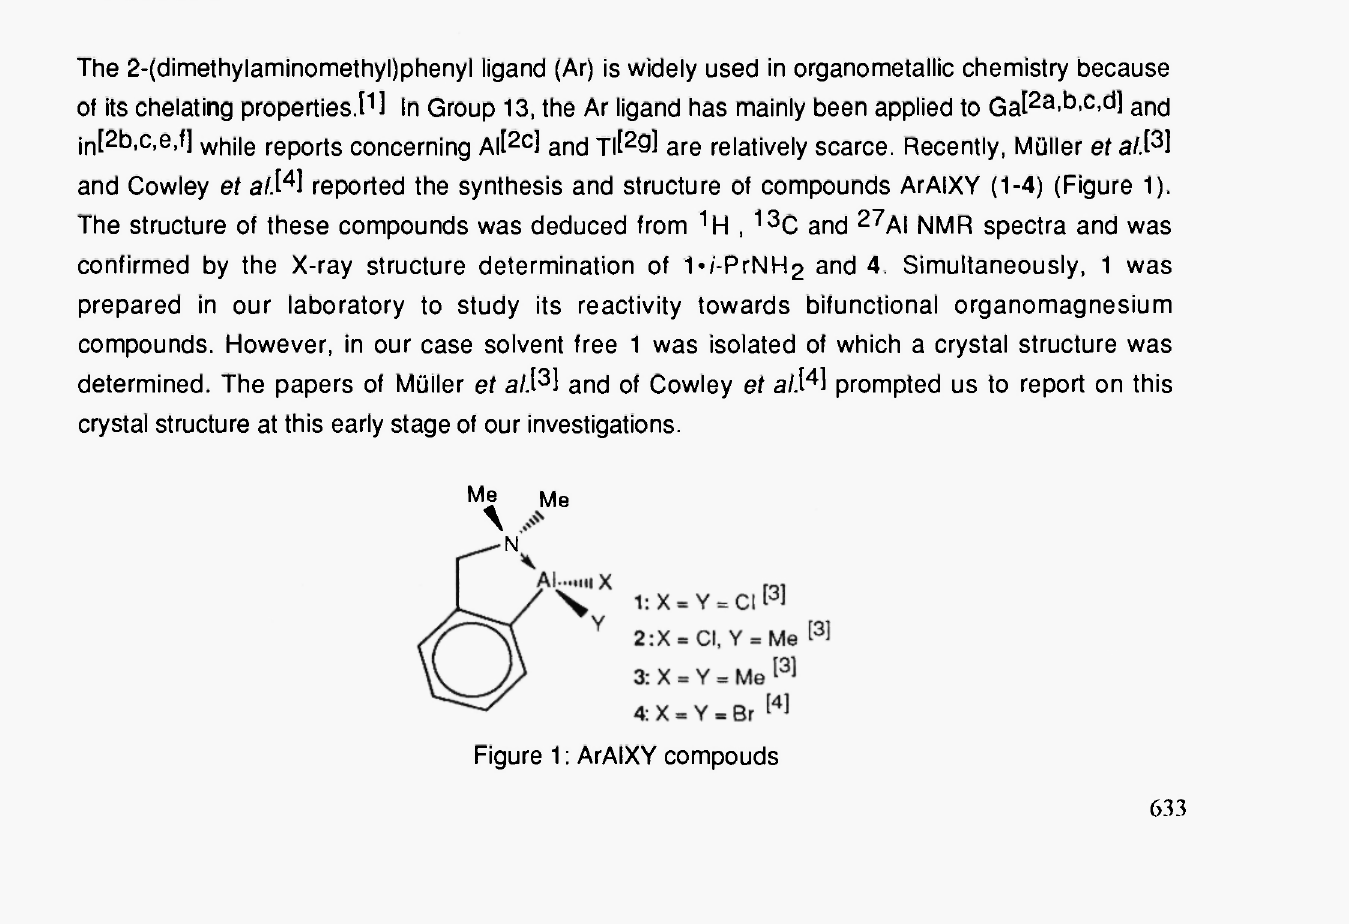
Figure 1: ArAIXY